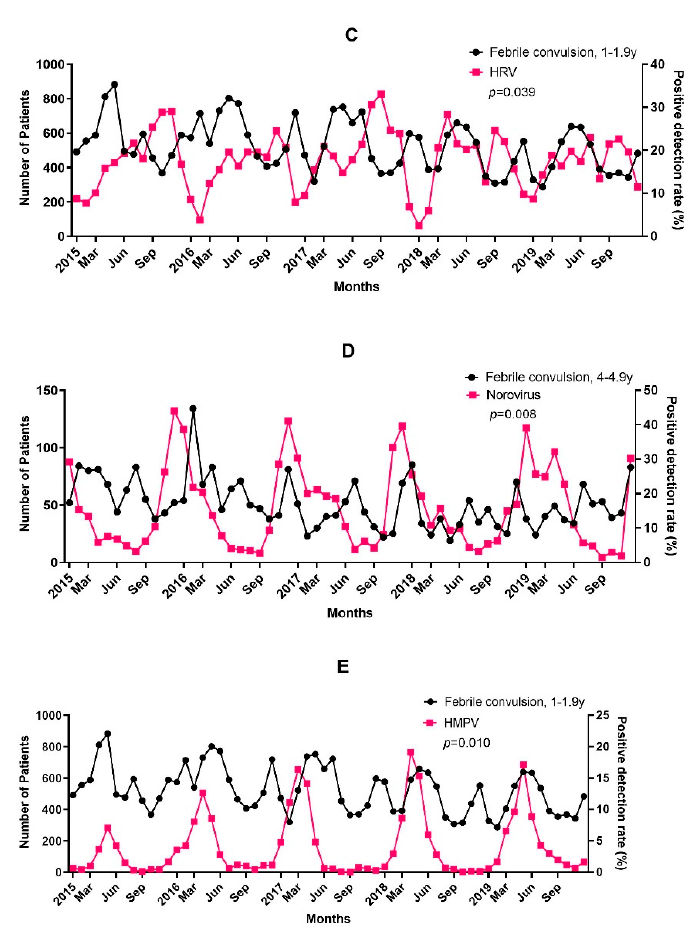
Figure 7. Relationship between PDR of ( A ) HRSV, ( B ) HCoV, ( C ) HRV, ( D ) HRSV, ( E ) HMPV and incidence of FC during the study period.